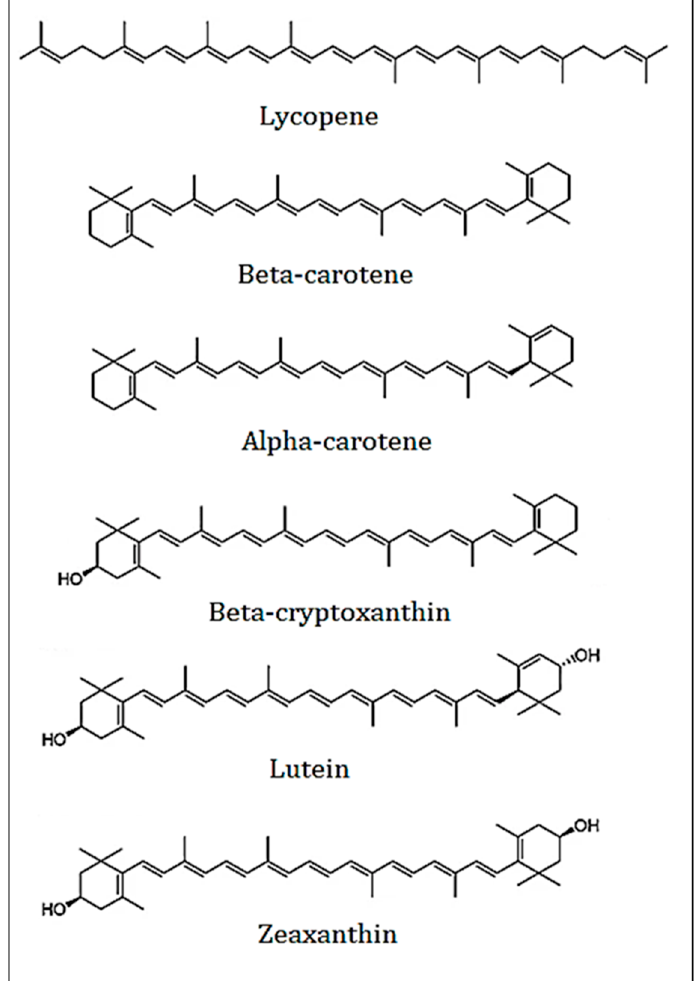
Figure 3. The constituent molecules that make up the chemical structure of various common plasma carotenoids. Table 1. Treatment of many contagious childhood illnesses with carotenoids.